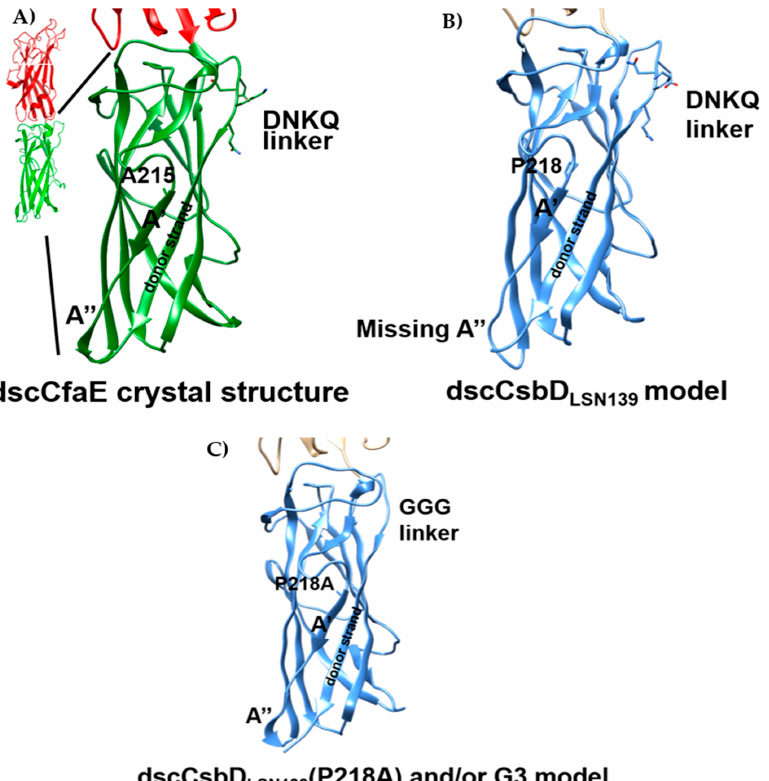
Figure 1. dscCfaE crystal structure and dscCsbD LSN139 structural models. ( A ) A’ strand, A’’ strand, DNKQ linker, alanine 215 and the donor strand were marked in the pilin domain of dscCfaE crystal structure (PDB ID: 2HB0). ( B ) A’ strand, the missing A’’ strand, DNKQ linker, proline 218 and the donor strand were marked in the pilin domain of dscCsbD LSN139 structural model. ( C ) A’ strand, the recovered A’’ strand, GGG linker, point mutation P218A and the donor strand were marked in the pilin domain of dscCsbD LSN139 (P218A) and/or G3 structural model. Based on the allele matching and analysis of the structural model, dscCsbD LSN139 , dscCsbD LSN139 (P218A), dscCsbD LSN139 (G3) and dscCsbD LSN139 (P218A/G3) were engineered and cloned using the csbD nucleotide sequence from the CS17 ETEC LSN139 allele.